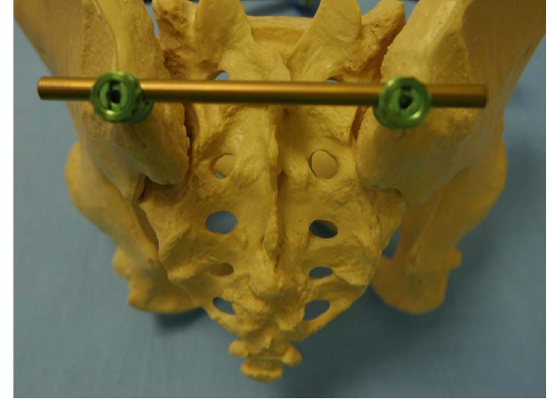
Figure 1. TIFI device on a bone